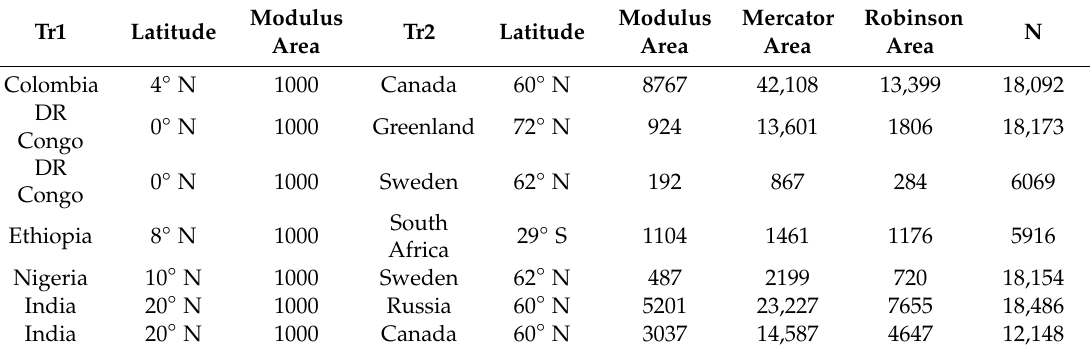
Table 2. Selection of pairs of test regions (tr1 and tr2) to analyze the Mercator e ff ect.